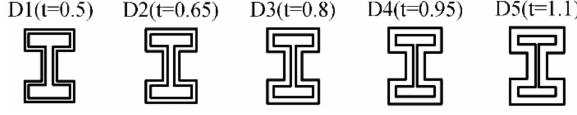
Figure 18. Cellular structures of different sizes t